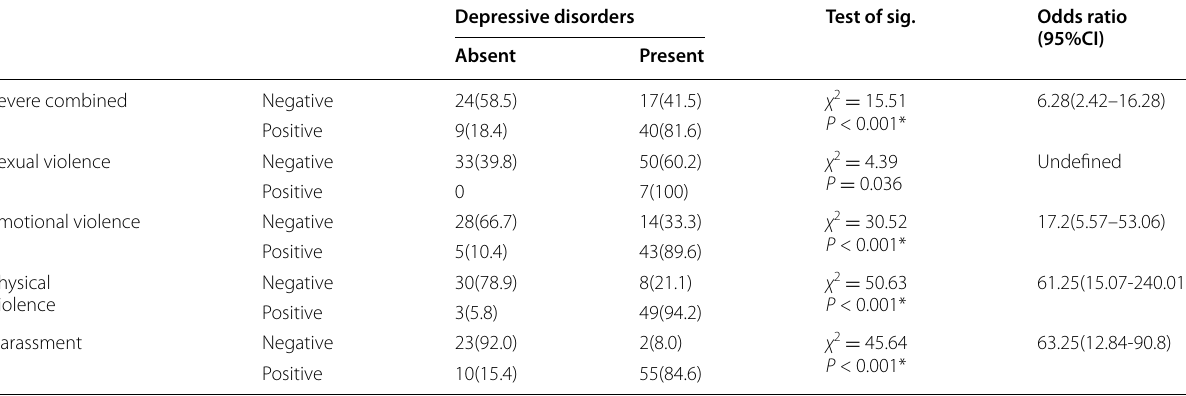
χ 2 chi-square test = *Statistically significant if P <